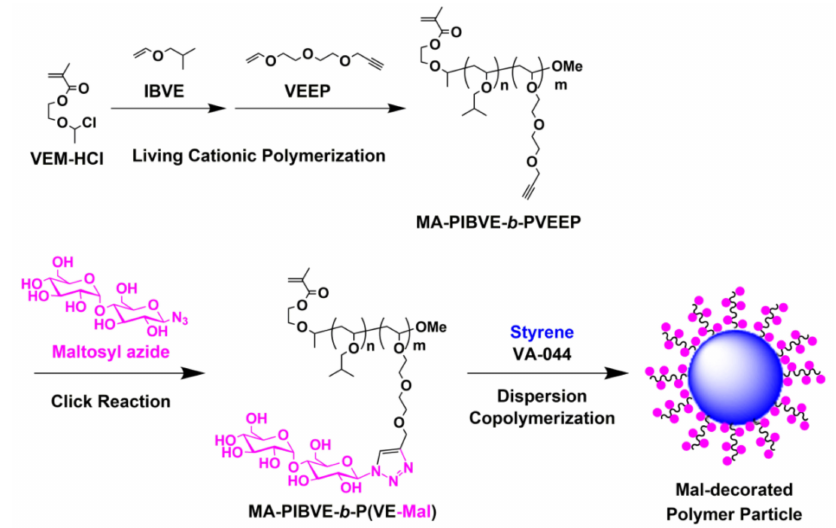
Figure 1. Synthesis of glycopolymer-type amphiphilic macromonomers (MA-PIBVE- b -P(VE-Mal)) and their application to the preparation of maltose-decorated (Mal-decorated) polymer particles by dispersion